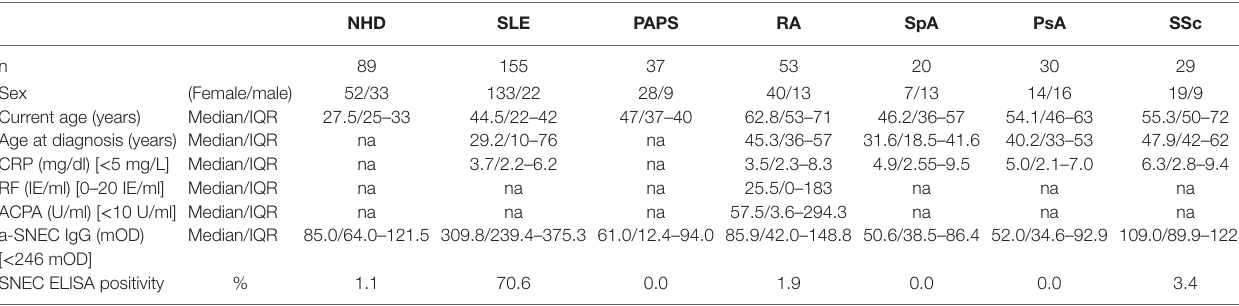
TaBle 1 | Demographical and serological characteristics of the study cohorts.